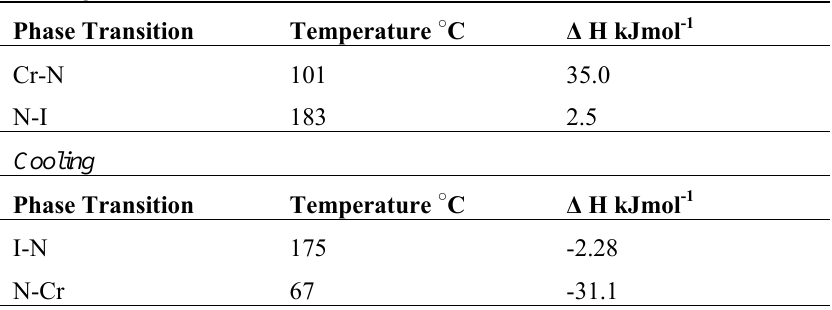
Table 4. Phase transition temperatures and enthalpy changes for compound 7